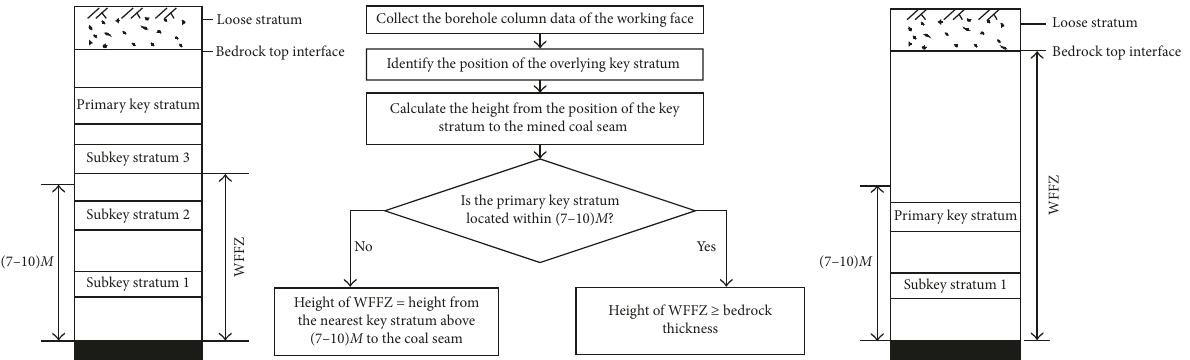
Figure 2: Prediction method flow chart for determining the height of the water flowing fracture zone based on the position of the key